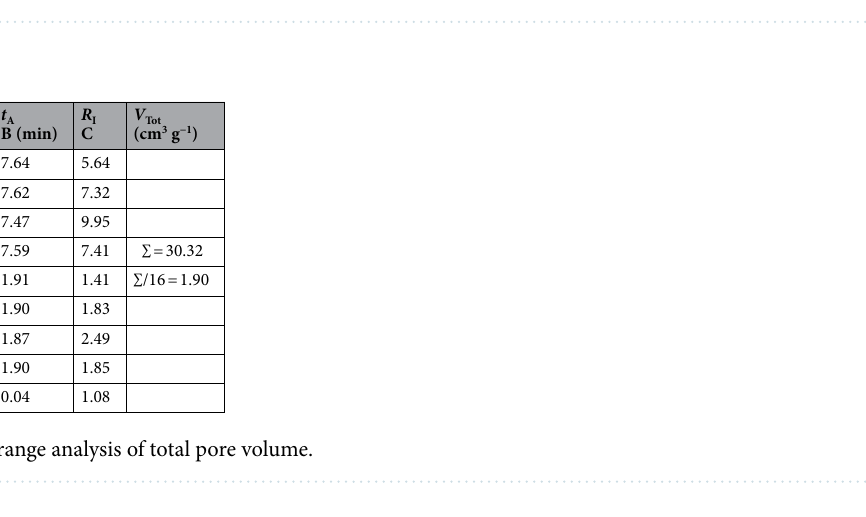
Table 5. The variance analysis of specific surface area. F 0.01 (3, 6) = 9.78; F 0.05 (3, 6) = 4.76; F 0.1 (3, 6) = 3.29. Where SV is the source of variation, SS is the sum of square, df is the degree of freedom, MS is the mean square.